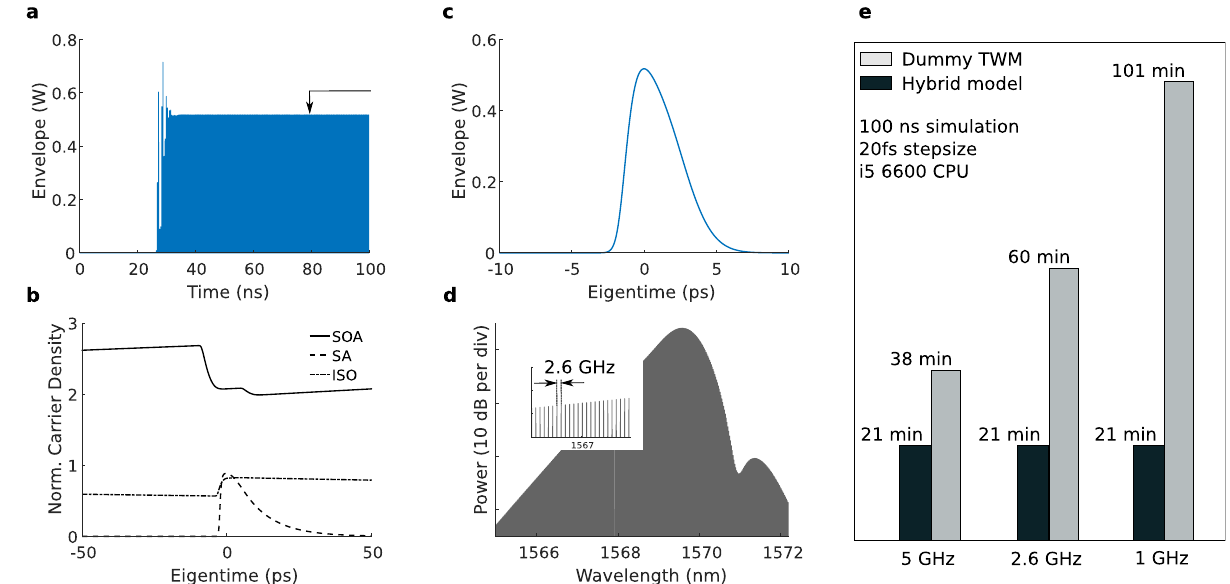
Figure 3. Mode-locked laser simulation example and benchmark. ( a – d ) Hybrid model output with a 20 fs stepsize and a 100 ns (260 roundtrips) duration. ( a ) Signal build-up at the output facet of the mode-locked laser. The arrow indicates the time instant of the corresponding normalized carrier densities ( b ) and pulse profile ( c ). ( d ) The optical comb spectrum corresponding with the generated pulse train. ( e ) Comparison of a dummy TWM and a hybrid model for a 5 GHz, 2.6 GHz and 1 GHz repetition rate. The hybrid model computation time is approximately invariant to the extended passive waveguide cavity size as it is not modeled by a slow TWM.